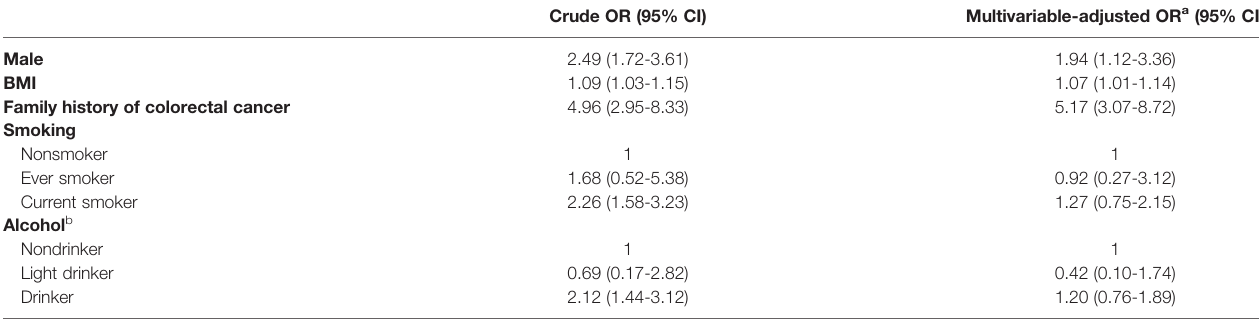
TABLE 2 | Risk factors associated with early-onset colorectal